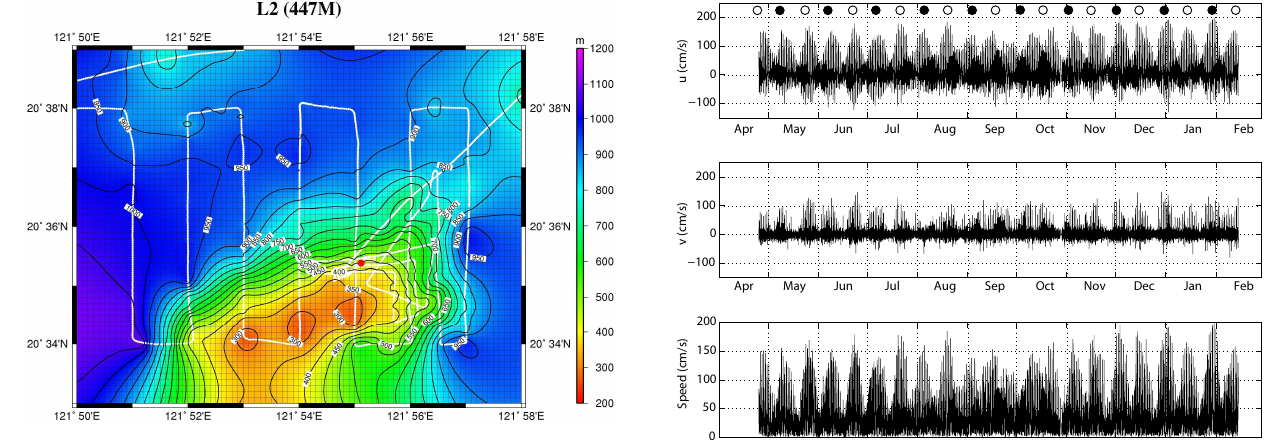
Fig. 9. Detail of the bottom topography near mooring L1 (red dot) based on a ship survey (white line) conducted from the Research Vessel OCEAN RESEARCHER 1. The seamount pictured is located in the gap between Batan and Itabayat Island (Fig. 1). Contours outside the sampling pattern have been extrapolated and have low confidence.